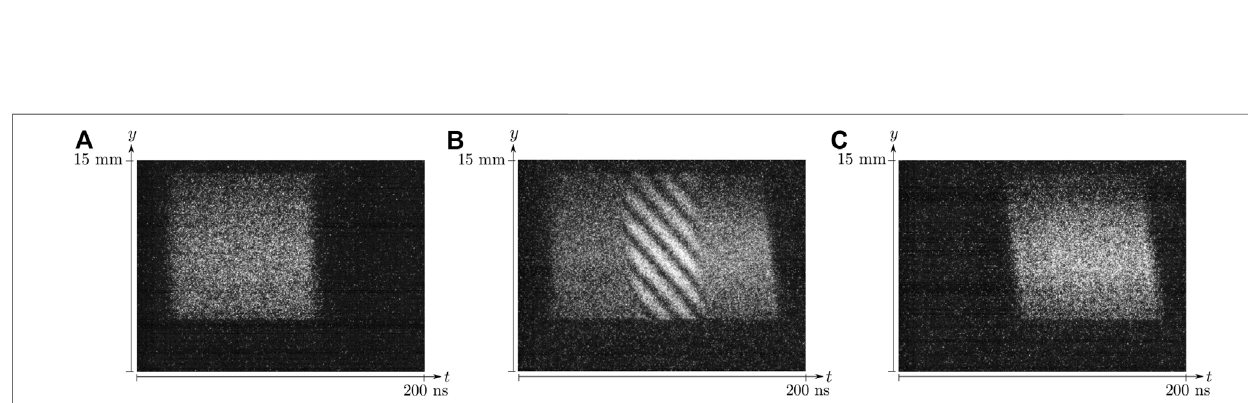
FIGURE 1 | Schematic diagram of the experimental arrangement. The setup is equivalent to a Young ’ s two slit experiment but each ’ slit ’ is illuminated by an independent laser.The slitscan beconceivedtobeplacedat any planebetweenthesources and thephotocathode detector beforethe beamsoverlap.(Optical beams drawn in red, electron beams within the streak camera drawn in green.)